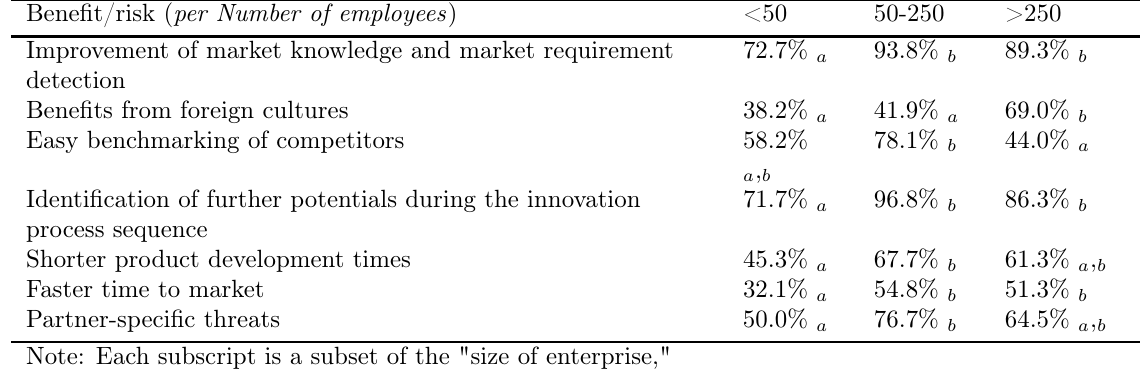
Table 9. Perception as a benefit/risk according to enterprise